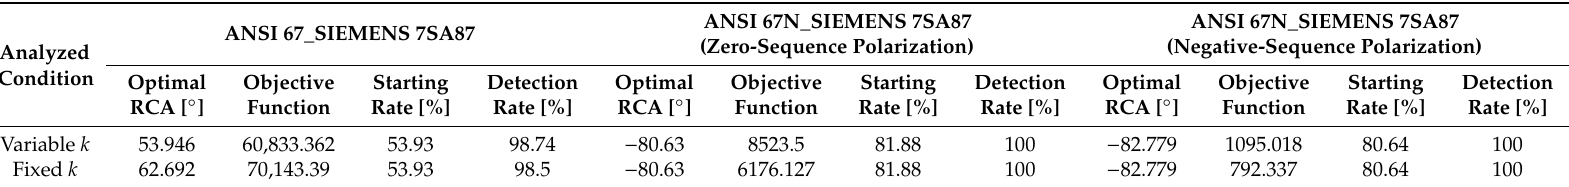
Table 5. Obtained results for the 7SA87 relay at LT_1 SE_B and optimal RCA.